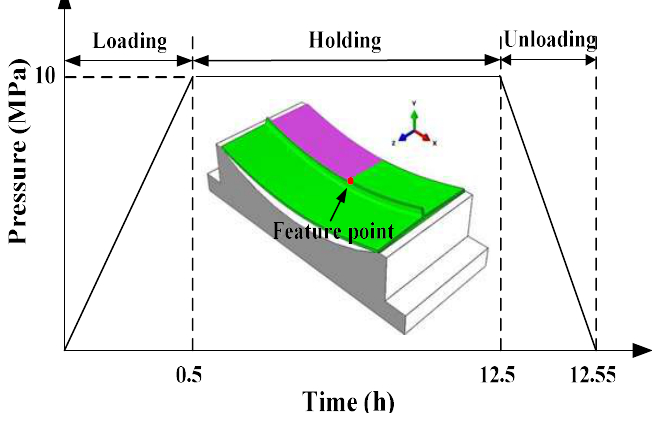
Figure 11. FE models and creep age forming (CAF) simulation procedure. Table 3. Mechanical property of AA7050 under 165 °C .